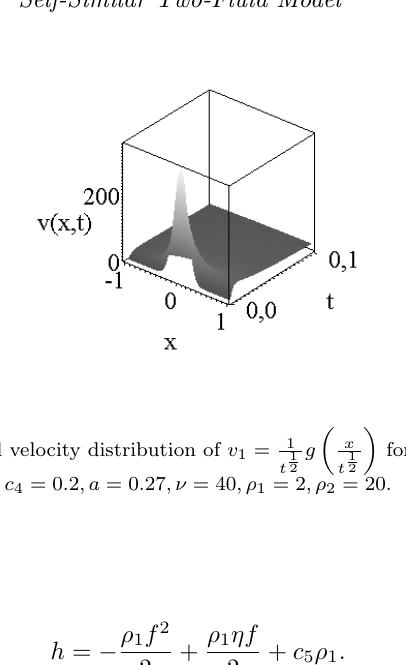
c 4 = 0 . 2 ,a = 0 . 27 ,ν = 40 ,ρ 1 = 2 ,ρ 2 = 20.